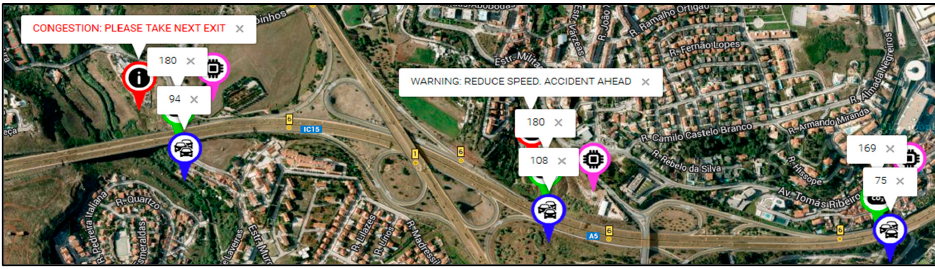
Figure 7. Alert messages received by the user: fragment of the demonstrator web application.